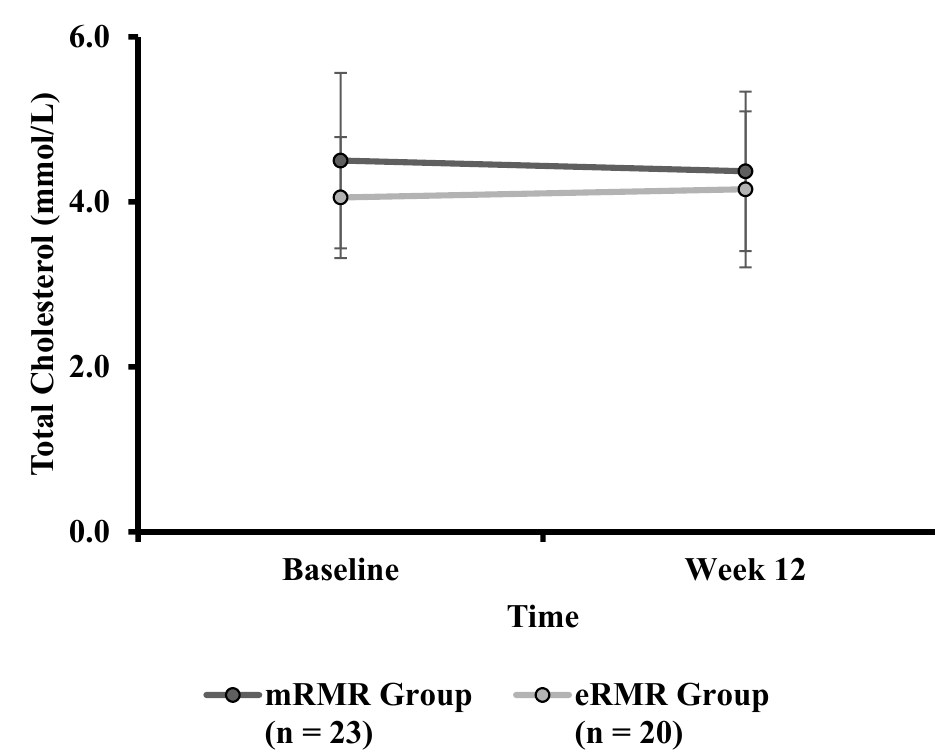
Figure 4. Total cholesterol (mmol/L) measured at baseline and week 12 for the mRMR ( n = 23) and eRMR groups ( n = 20). 3.14. High-Density Lipoprotein